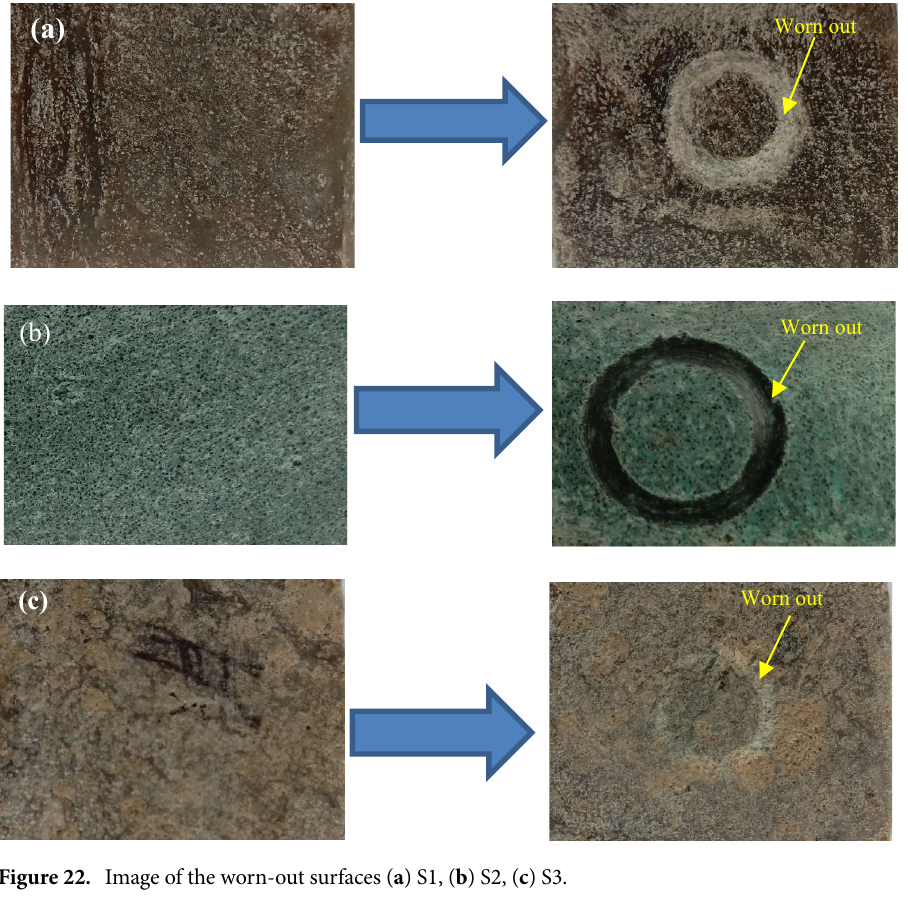
Figure 22. Image of the worn-out surfaces ( a ) S1, ( b ) S2, ( c ) S3.